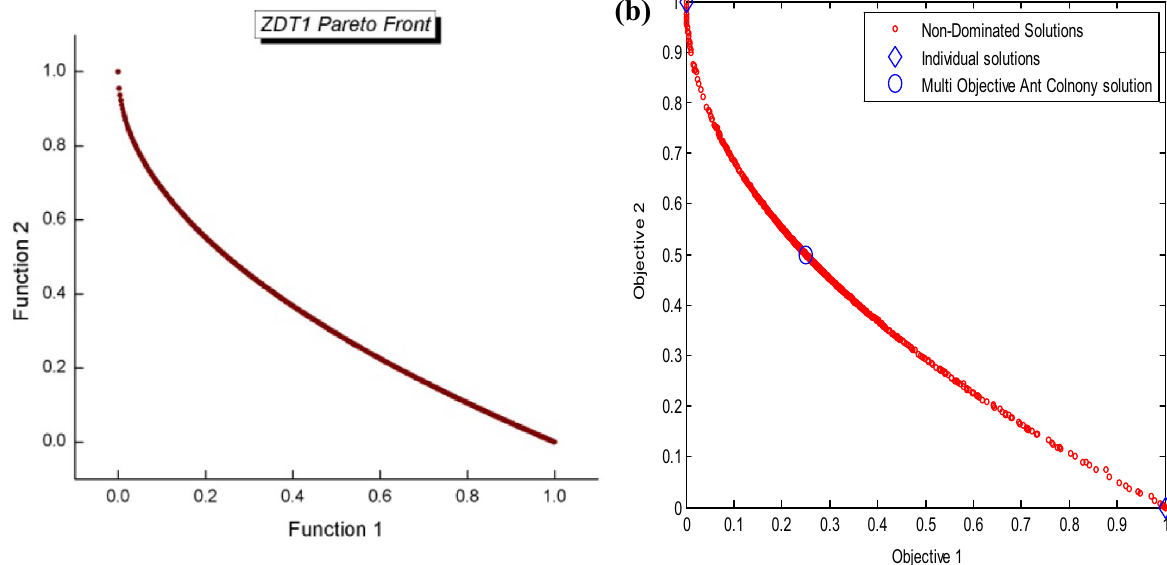
Fig. 3 Pareto front of ZDT1 a standard Pareto front (Deb 2010) and b obtained by multiobjective ant colony